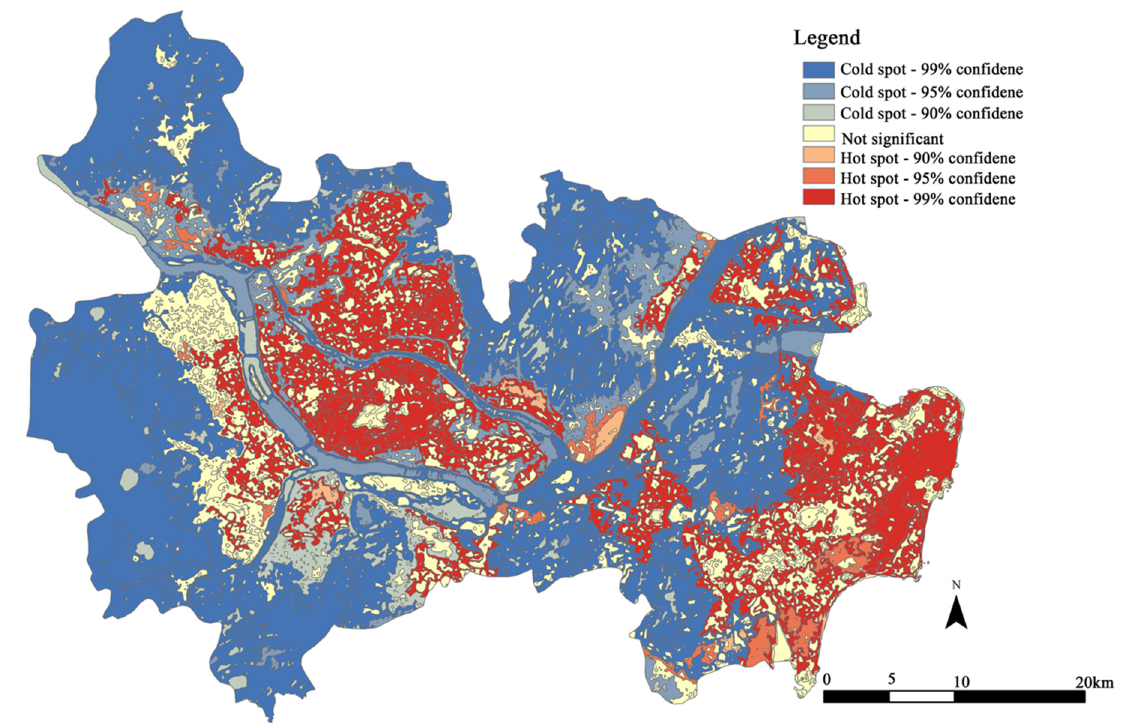
Figure 3. The cold spots and hot spots spatial distribution.